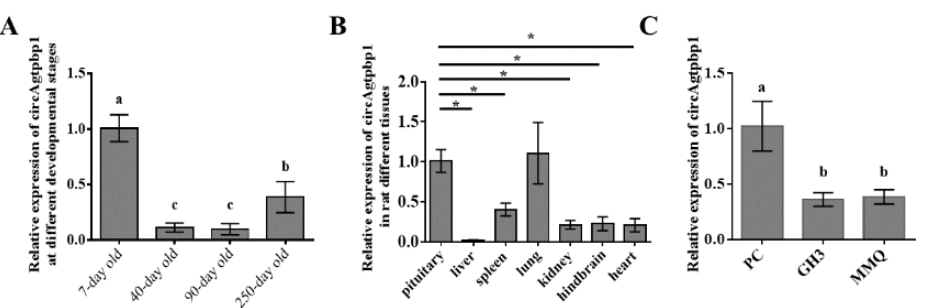
Figure 2. CircAgtpbp1 expression pattern in rat anterior pituitary. ( A ) RT–qPCR analysis of circAgtpbp1 the relative expression in different stages. ( B ) The relative expression level of circAgtpbp1 in mature rat different tissues. ( C ) CircAgtpbp1 expression in rat pituitary primary cell and GH3, MMQ cell lines. At least three replicates of each experiment were performed. Mean values and standard deviations (SD) of data are shown. One-way ANOVA and independent-samples t-test were applied to determine statistical significance. p < 0.05 was considered significant. Different letters (a, b and c) indicate significant differences between groups ( p < 0.05). *, p < 0.05.